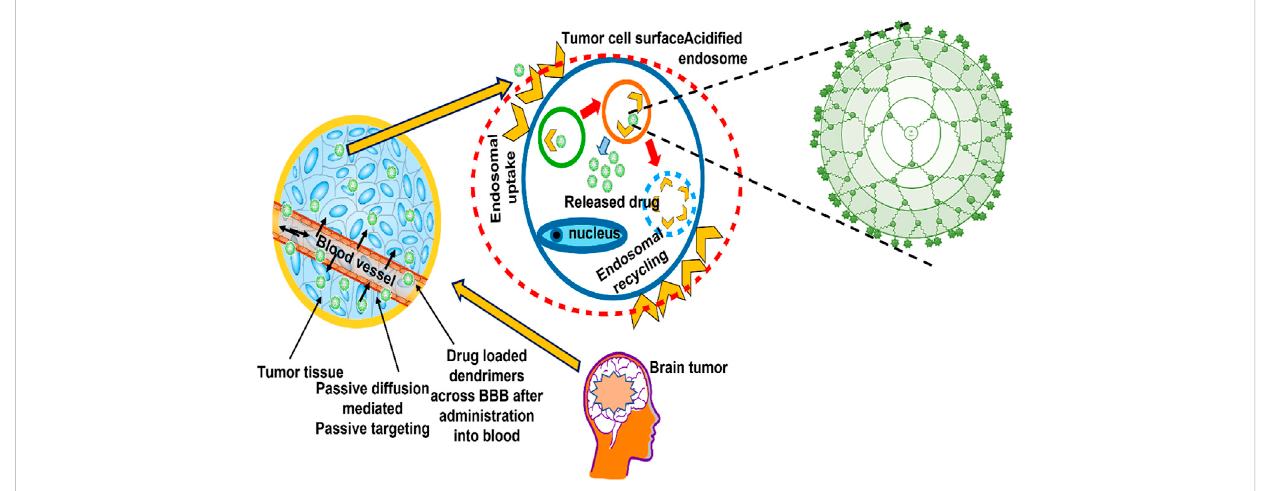
FIGURE 4 Drug targeting approaches (active and passive) mediated by dendrimers in brain